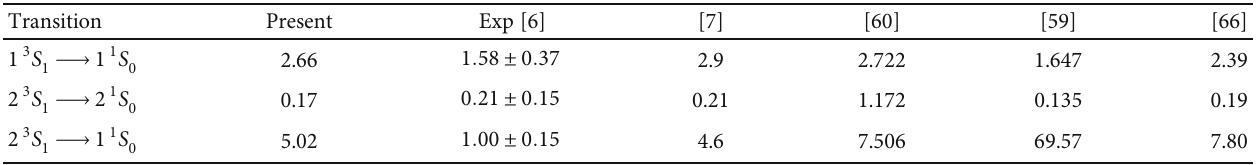
Table 5: M 1 radiative partial widths (in